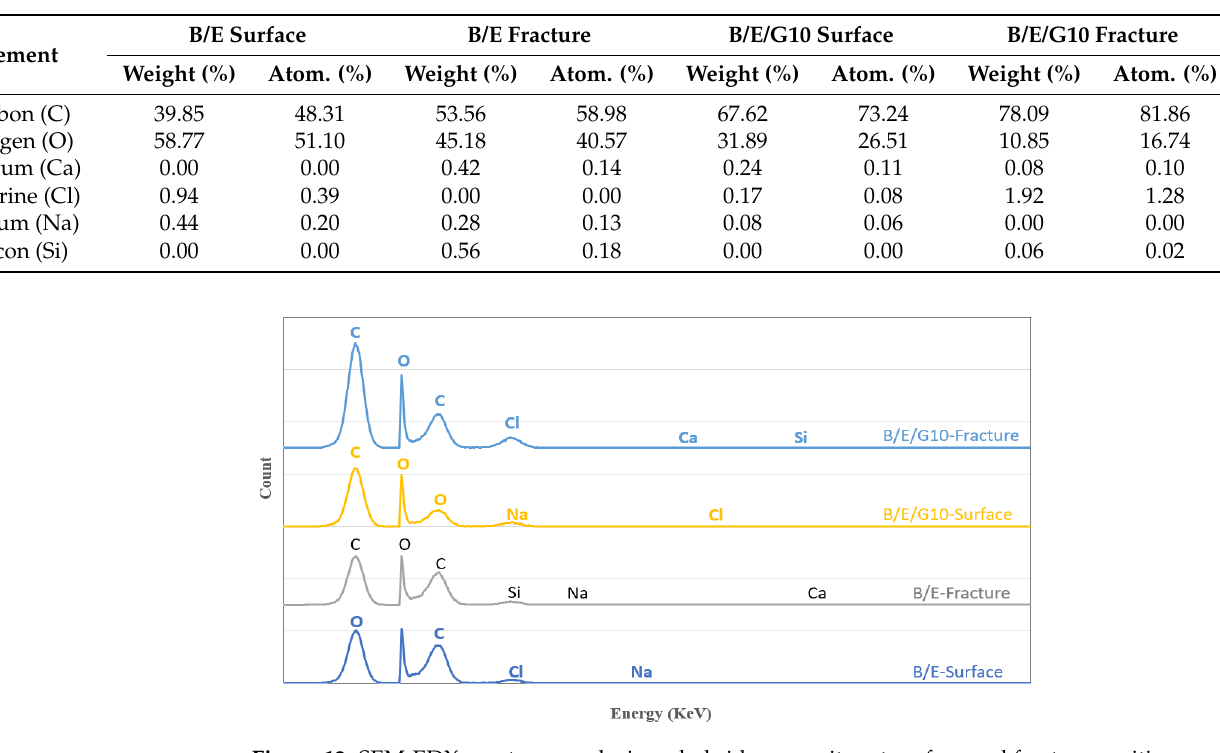
Table 3. The chemical composition of basalt and E-glass hybrid composites at surface and fracture position.